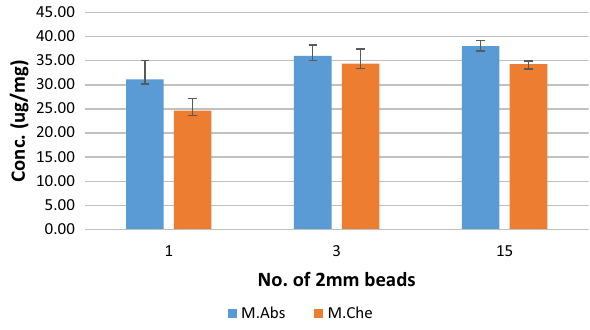
Fig. 3 Plot of amount of proteins extract (µg/mg) vs number of 2 mm glass bead used for sonication lysis method with GuHCl as extraction solvents. Abs = M. abscessus , Che = M. chelonae